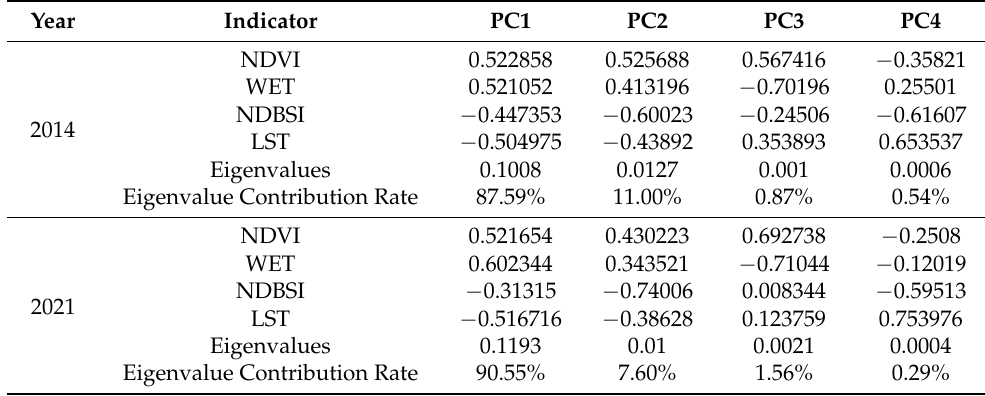
Table 1. Remote sensing ecological index calculation equation based on Landsat.